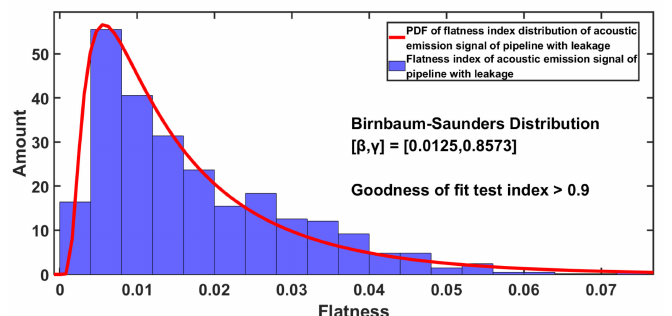
Figure 12. Distribution of the spectral flatness of the acoustic emission signals of WDSs with a